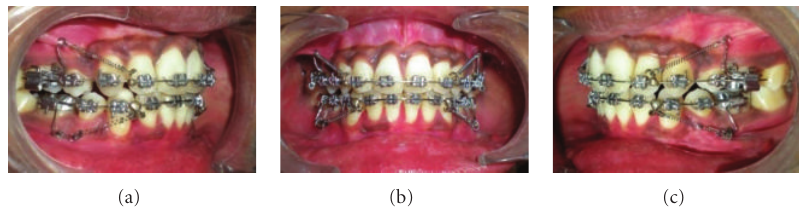
Figure 11: (a, b, c) Midlines were corrected just before completion of space closure using interarch anterior diagonal elastics.